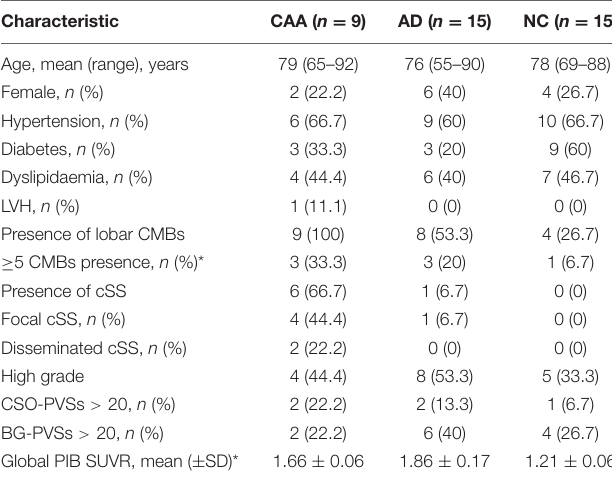
TABLE 2 | A comparison of demographic, clinical, and neuroimaging characteristics among the CAA, Alzheimer’s disease (AD), and cognitively normal healthy control (NC)